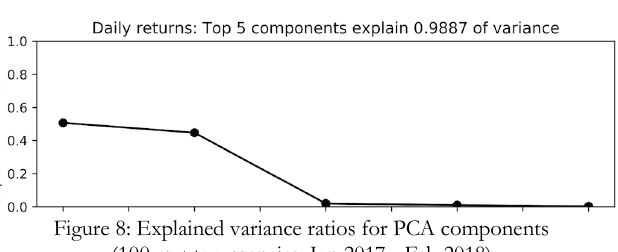
Figure 7: Explained variance ratios for PCA components (73 cryptocurrencies, Jan 2016 - Feb 2018)